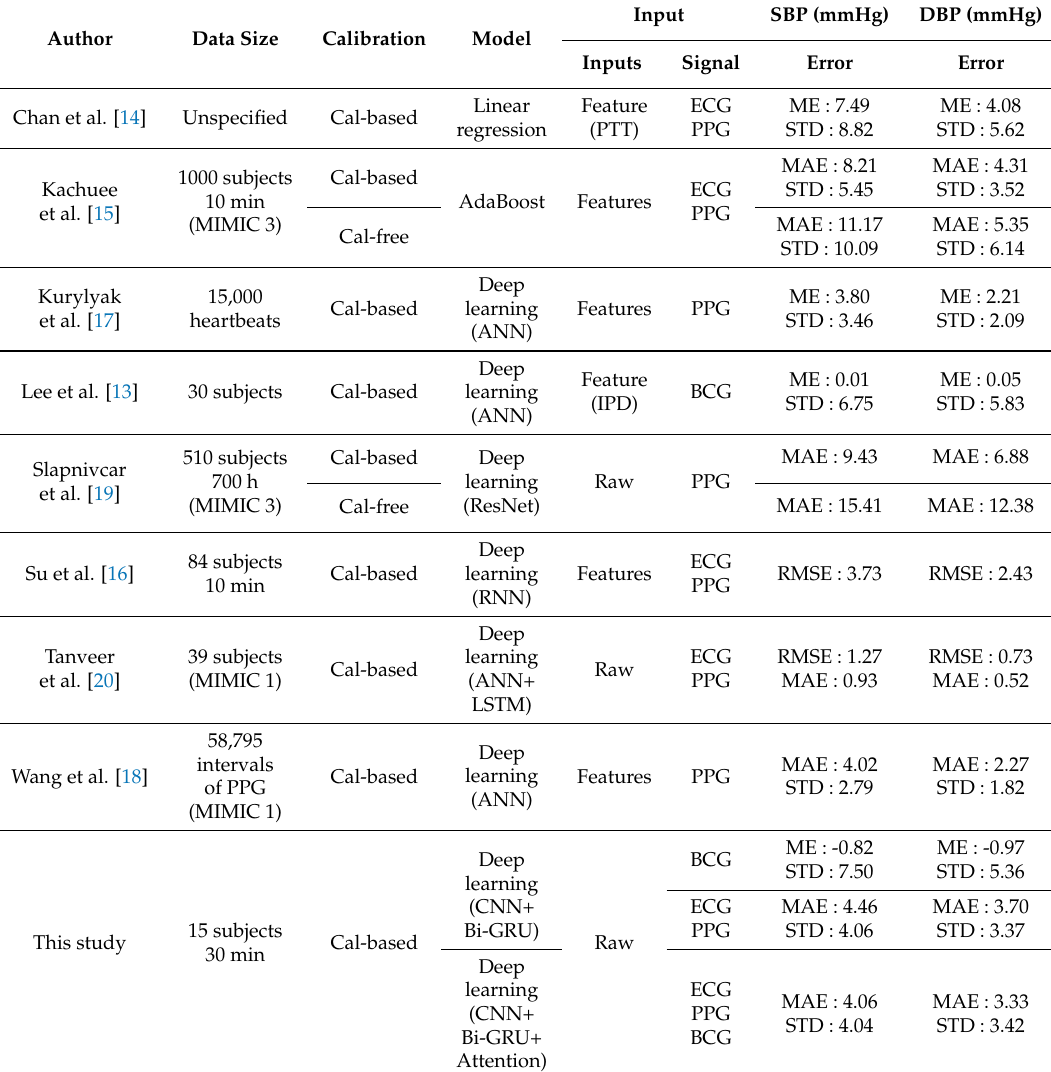
Table 10. Performance comparison with related works.